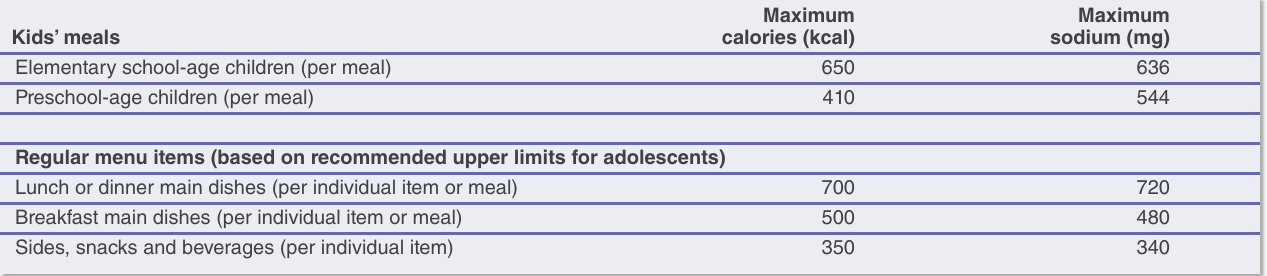
Table A1. Maximum acceptable calories and sodium for kids’ meals and individual menu